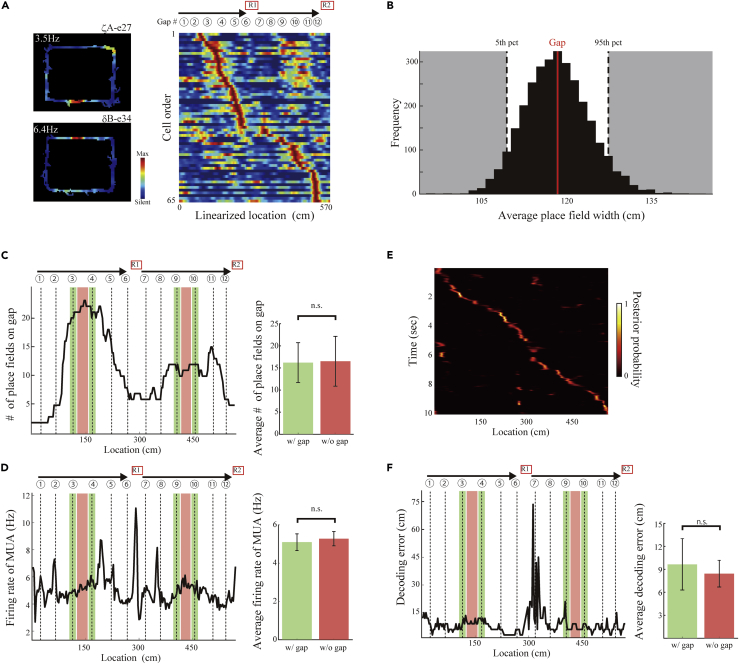
Interlocking Gaps Do Not Alter Hippocampal Place Coding(A) Left, normalized firing rate map of two representative place cells that have place fields around gap locations in the hippocampal CA1 on the square-shaped maze configuration. Right, normalized firing rate maps of 65 hippocampal place cells simultaneously monitored from a rat (ζA) ordered by the latency of their peak firing rates. Each line is a single unit. Gap locations are indicated at the top. Red indicates maximum firing rates, and blue indicates silent.(B) Distribution of the average width of place fields randomly shuffled from the original sample covering the gaps (3,000 shuffles). Red line indicates the average width of the place fields on the gaps. Dotted lines indicate 5th and 95th percentiles for the shuffled data.(C and D) Left, the number of place fields (C) and the firing rate of multi-unit activity (MUA) in the hippocampal CA1 (D) as a function of linearized location on the square-shaped maze. Right, the average number of place fields (C) (z = 0.14, p = 0.89) and the average firing rate of MUA (z = −1.51, p = 0.13) on the gaps (#3, 4, 9, 10) (green shaded area) and between them (orange shaded area).(E) Representative posterior probability of locations decoded by the Bayesian decoder from 89 simultaneously monitored cells. Values are indicated by the color bar (right).(F) Left, the difference between actual and decoded locations as a function of linearized location on the square-shaped maze. Right, the average difference between actual and decoded locations on the gaps (#3, 4, 9, 10) (green shaded area) and between them (orange shaded area) (z = 1.34, p = 0.18). Bin width is set at 3 cm.All error bars indicate SEM. All were from two-tailed Wilcoxon rank-sum test, n.s.: p > 0.05.